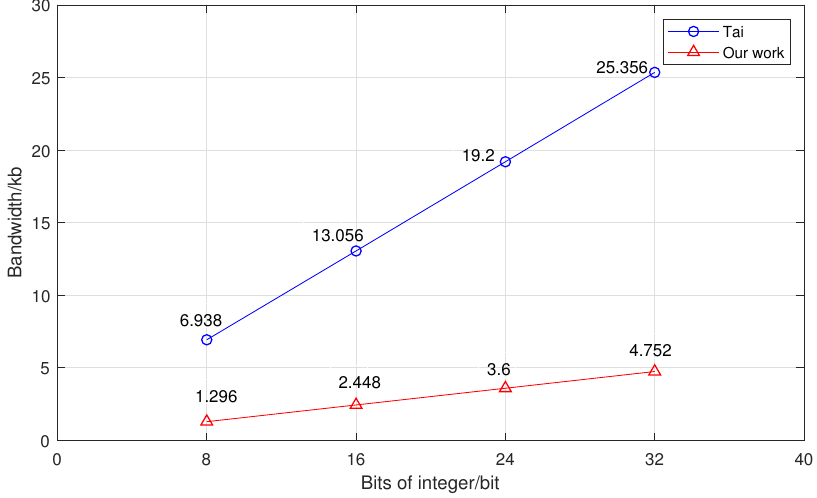
Figure 6. The relationship between the runtime and integer size [11].